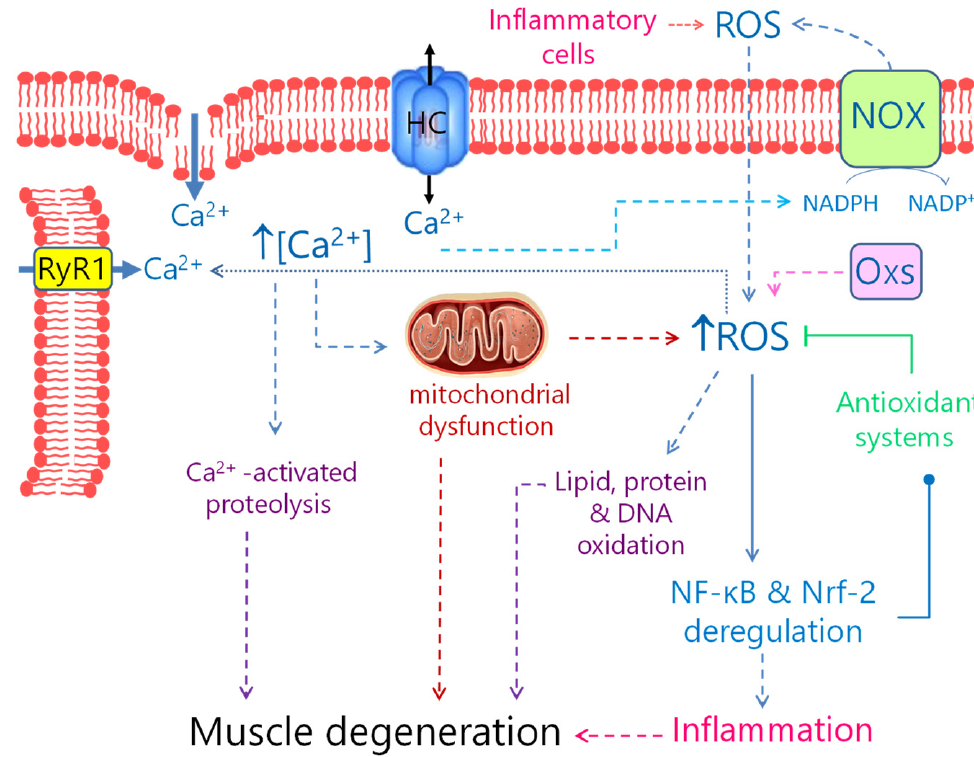
Figure 2. Mechanisms contributing to muscle dystrophy progression. Mutations in proteins that critically regulate skeletal muscle integrity and homeostasis can cause myofiber damage with con- secutive accumulation of inflammatory cells that produce ROS. In muscular dystrophies (MDs), such as Duchenne muscular dystrophy (DMD), myofibers also display sarcolemma microtears that allow Ca 2+ entry. The de novo expression of non-selective channels, such as connexin hemichannels, can further contributes to excessive high cytosolic Ca 2+ concentrations, which in turn might lead to activation of Ca 2+ -activated proteases, mitochondria dysfunction and reactive oxygen species (ROS) generation from mitochondria, NADPH-oxidase (NOX) and oxidases (Oxs) such as xanthin oxidase. ROS overproduction leads to Ca 2+ leak from the sarcoplasmic reticulum via ryanodine receptors (RyR1), oxidation of lipids, proteins and DNA, and deregulation of the nuclear factor kappa B (NF- κ B) and nuclear factor erythroid-derived 2-related factor 2 (Nrf2) signaling pathways, which regulate the expression of inflammatory mediators and antioxidant enzymes. All these elements contribute to muscle